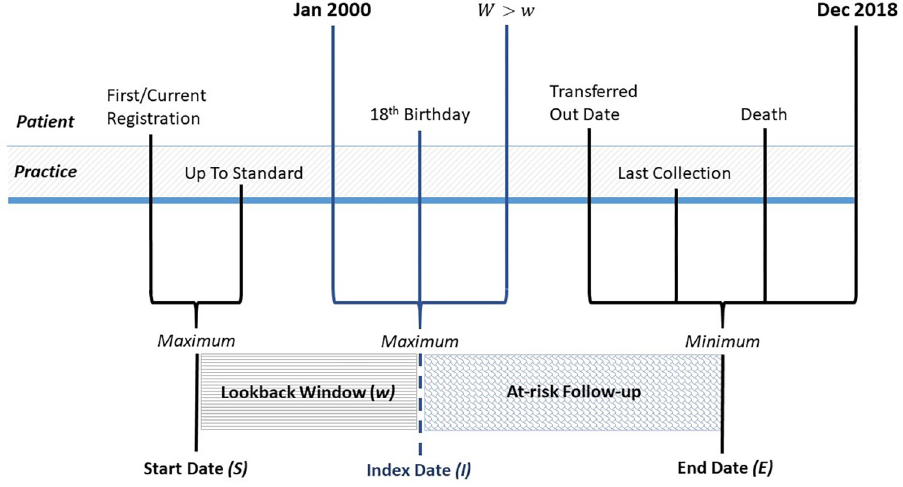
Fig 1. Subject timelines with patient and practice level dates used to derive start date ( S ), index date ( I ) and end date ( E ). Lookback window ( w ) and at-risk follow-up period